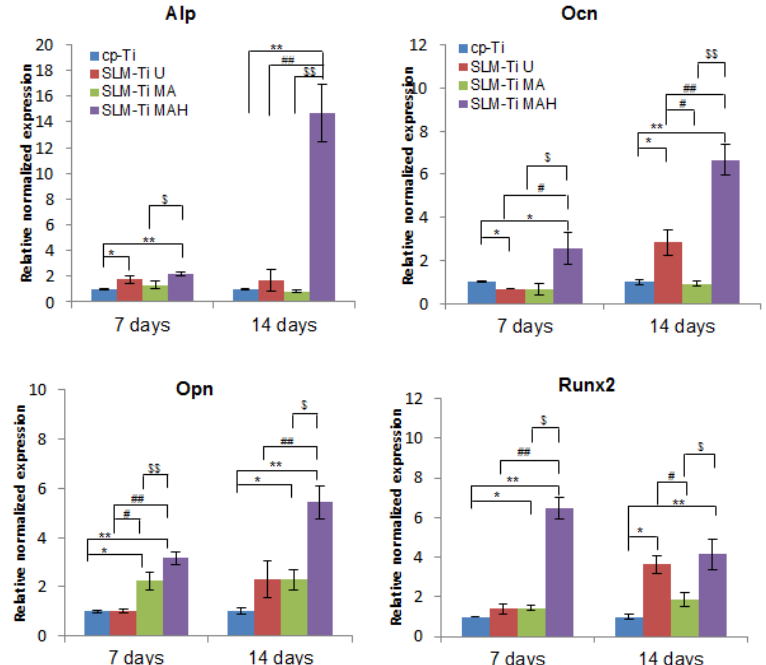
Figure 10. Real-time PCR for osteogenic gene expression of MC3T3-E1 cells cultured on cp-Ti and SLM-Ti with or without bioactive treatment at 7 and 14 days. The data were normalized to GADPH. All values are presented as the mean ± sd (n = 3), * different from cp-Ti at * p < 0.05, ** p < 0.01; # different from SLM-Ti U at # p < 0.05, ## p < 0.01, $ different from SLM-Ti MA at $ p < 0.05, $$ p < 0.01.